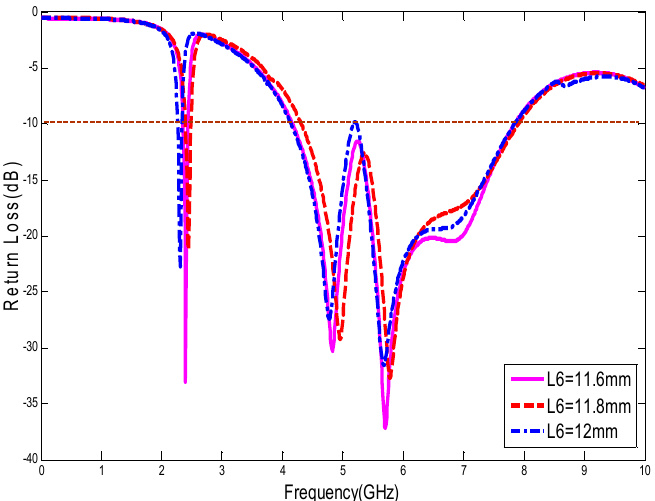
Figure 9. Simulated return loss versus frequency for the proposed antenna for various values of L 6 ; other parameters are the same as those listed in Table 2.